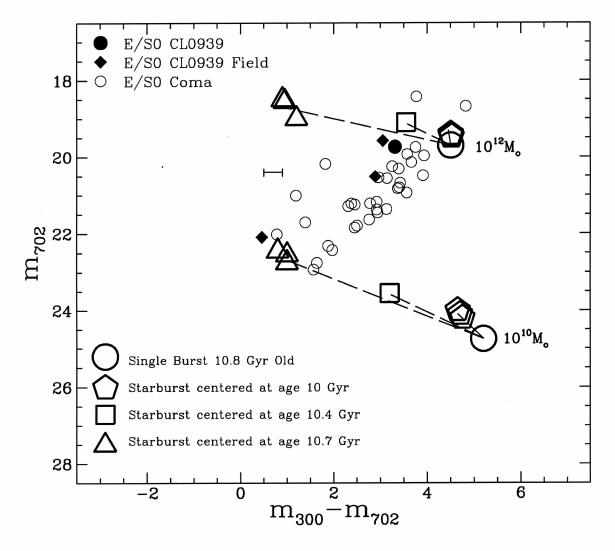
Figure 7. Dwarf galaxies in Abell 851 and Coma Clusters. Models showing the expected location of both passively evolved and young population contaminated ETGs, superimposed to the UV/optical C-M diagram for ETGs of both Abell 851 and Coma Clusters. Both models and galaxy magnitudes have been scaled to z = 0.41. The meaning of symbols, both for data and models, is given by the key in the figure. On the right side are represented galaxy models at a fixed age of 10.8 Gyr with mass of 10 10 , 10 11 , and 10 12 M respectively, which consist ⊙ of an aging, uncontaminated single-burst population. Dashed lines connect both the highest and lowest mass models to their expected location in case they have experienced recent “rectangular" bursts having constant duration ( 10 8 yr) and slightly different efficiencies β 2 (within 1% to 3%), centered at a time T of 0.1, 0.4, and 0.8 Gyr before the epoch recorded by b the observations, respectively. Multiple symbols correspond to the above slightly different efficiencies of the recent burst. The dot-dashed line represents the FOCA detection limit for UV observations of Coma Cluster galaxies. Reproduced with permission from